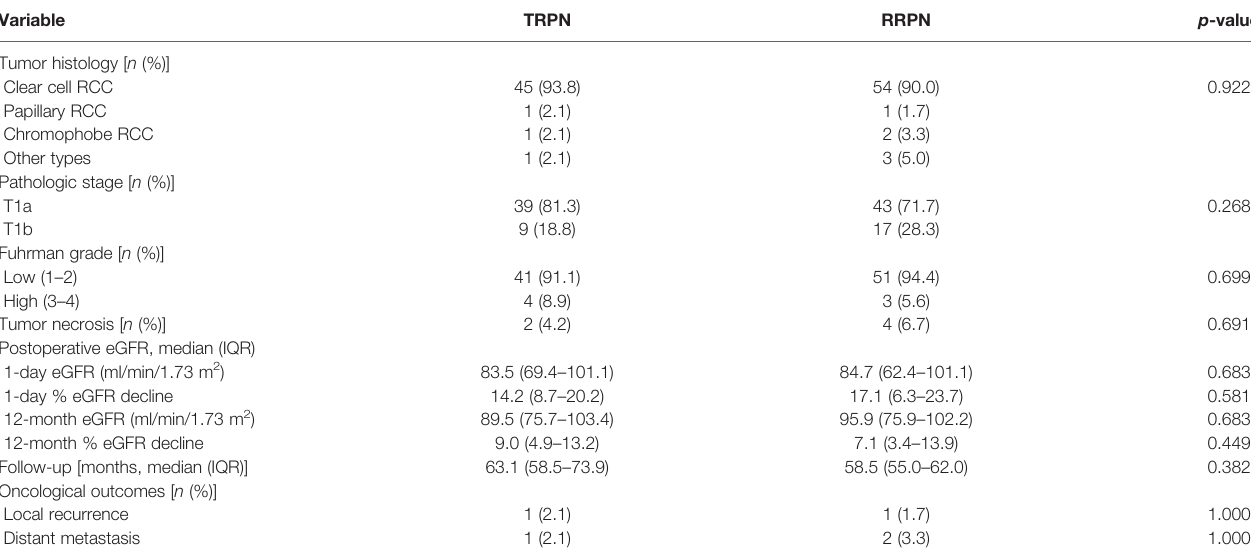
TABLE 3 | Pathological outcomes and follow-up data.